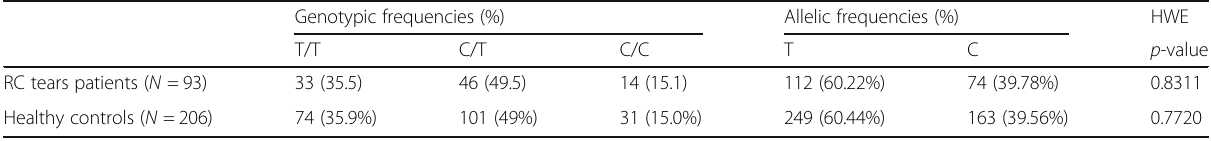
Table 1 HWE assessment and case-control association analysis of COL5A1 rs12722 variant by allele and genotype Genotypic frequencies